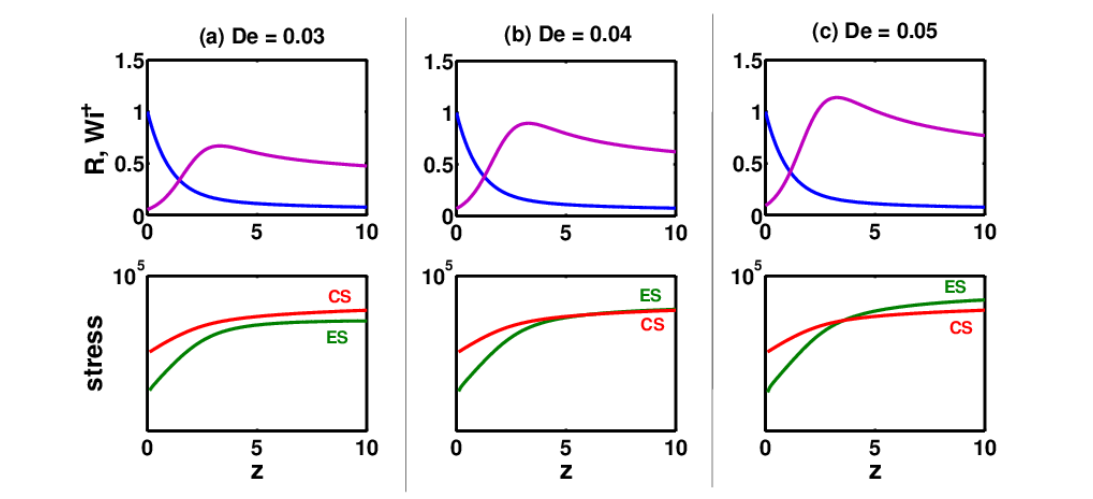
Figure 4. Growth of elastic stresses (ES) and capillary stresses (CS) as the jet begins to thin from the nozzle tip ( z = 0) until the onset of whipping ( z = 10) for three polymer solutions with constant φ 0 = 0.02 but different De values: ( a ) De = 0.03, ( b ) De = 0.04 and ( c ) De =